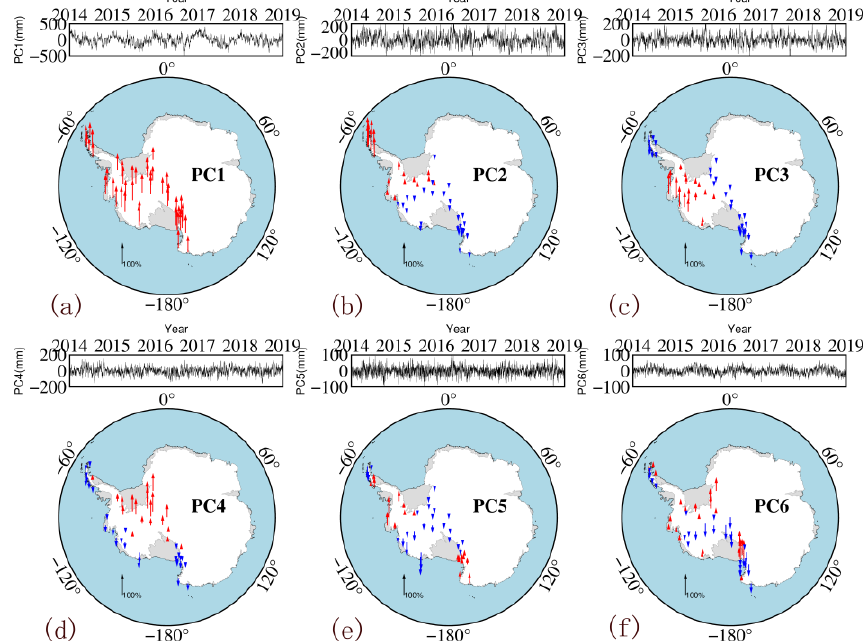
Figure 5. Six principal components (PC) of principal component analysis (PCA) solution. From ( a) to ( f) are PC1, PC2, PC3, PC4, PC5 and PC6, respectively. (The time series at the top of each panel shows the PC of each component; the maps at the bottom show the normalized spatial responses (red: positive response; blue: negative response)).